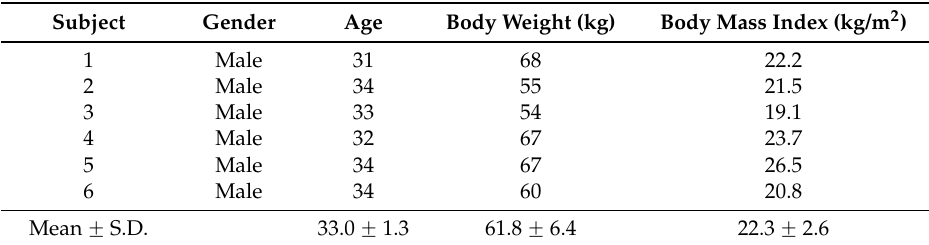
Table 1. Characteristics of the six subjects.